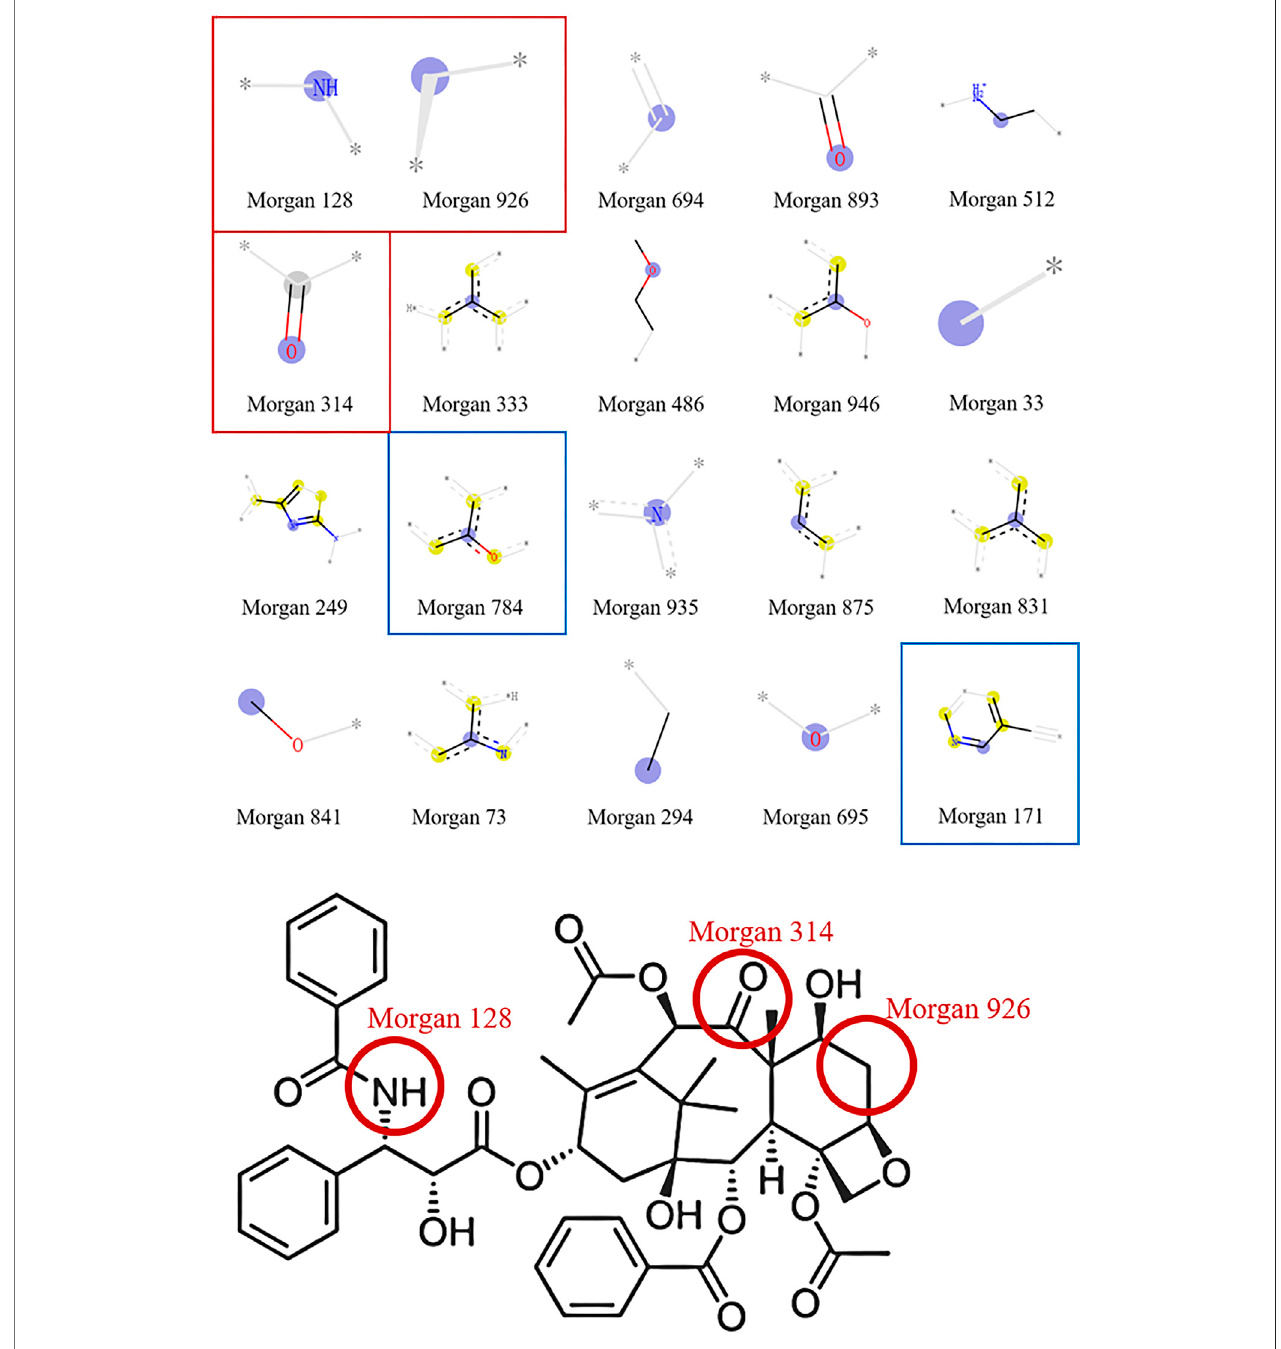
FIGURE 9 | Important molecular substructures of the RF:Morgan model in MDA-MB-231 and the chemical structural of paclitaxel.